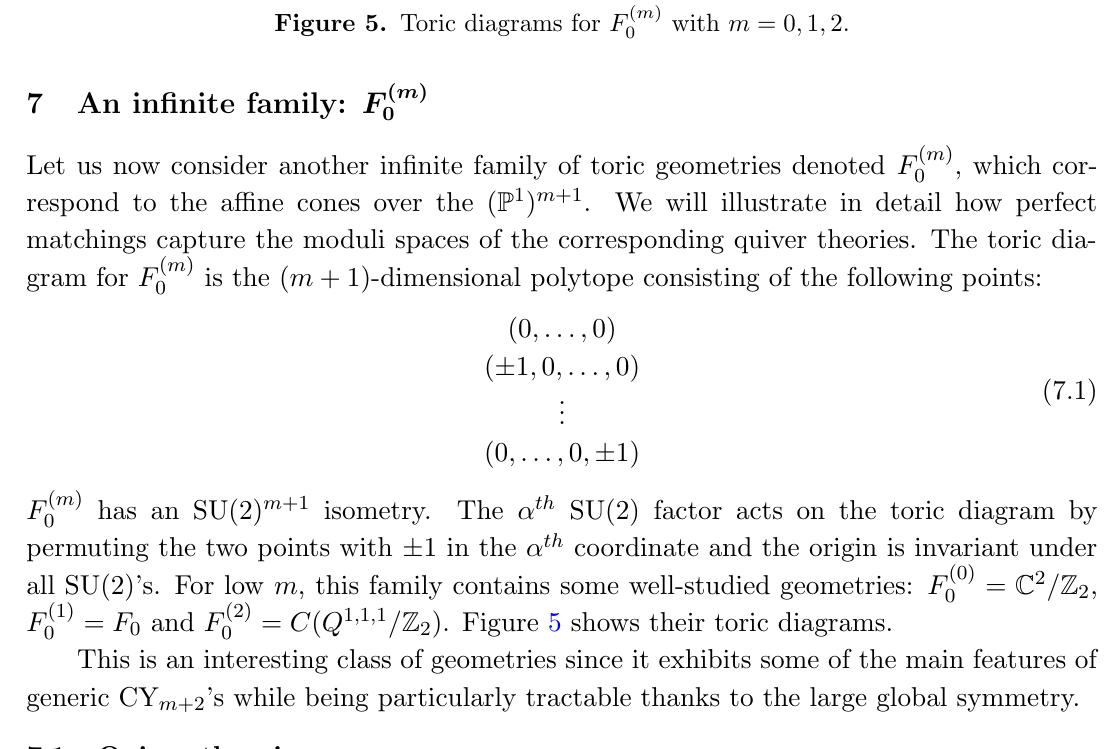
Figure 5. Toric diagrams for F ( m )